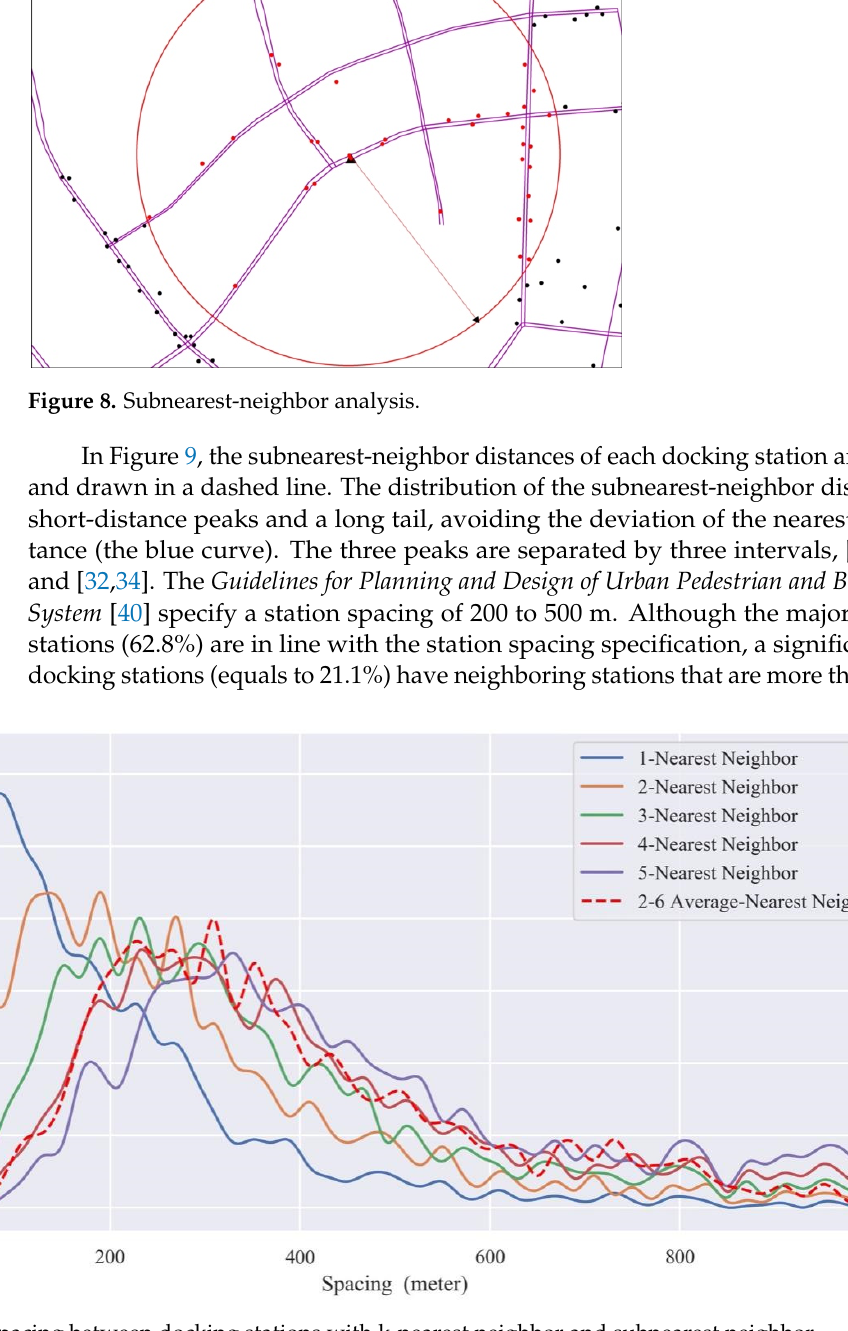
Figure 9. Spacing between docking stations with k-nearest neighbor and subnearest neighbor.